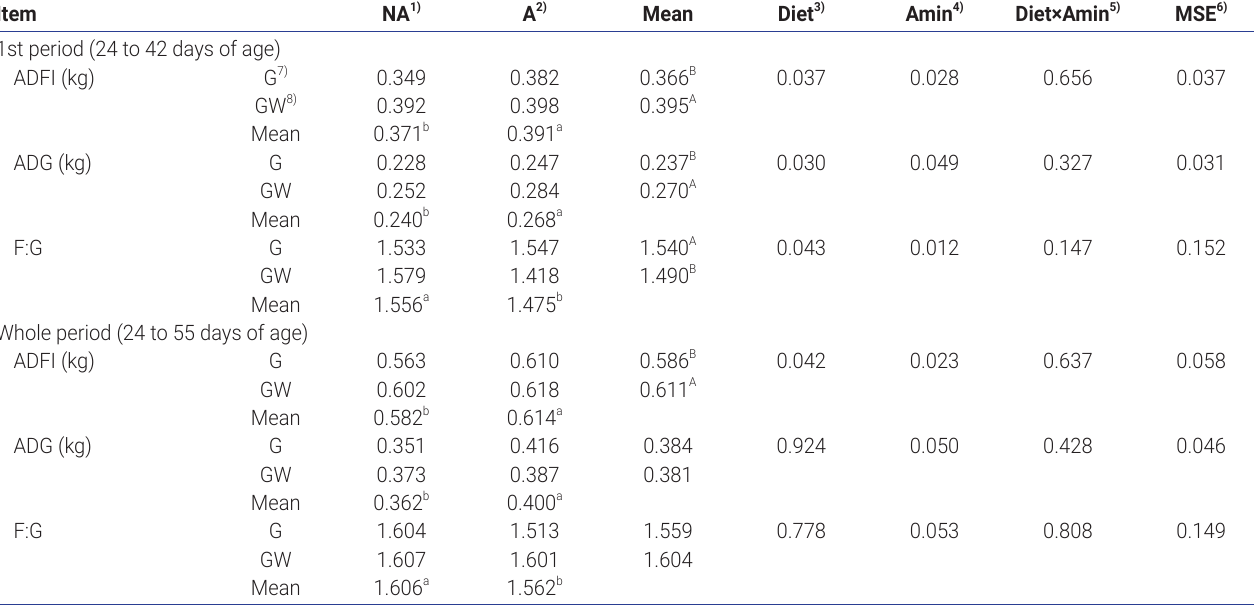
Table 2. Influence of supplementation of L-glutamine + L-glutamic acid whey powder in weaned piglets